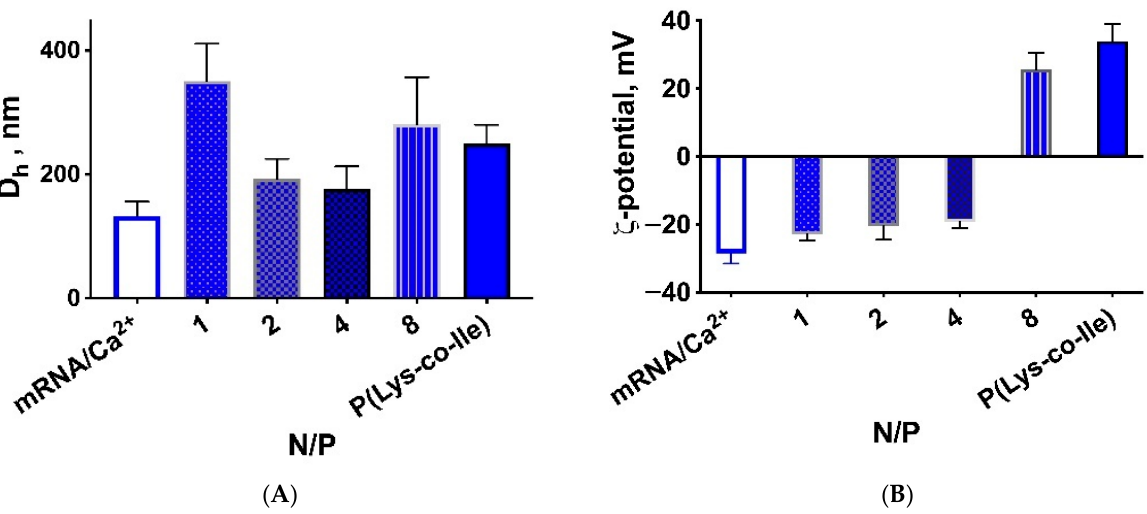
Figure 3. The effect of cationic polypeptide addition to mRNA/Ca 2+ at different proportions on size ( A ) and ζ -potential ( B ) of formed polyplexes. The presented data were obtained for P(Lys-co-Ile)-3 copolymer. The measurements were performed in ultrapure H 2 O. Results are given as Mean ± SD ( n = 3).